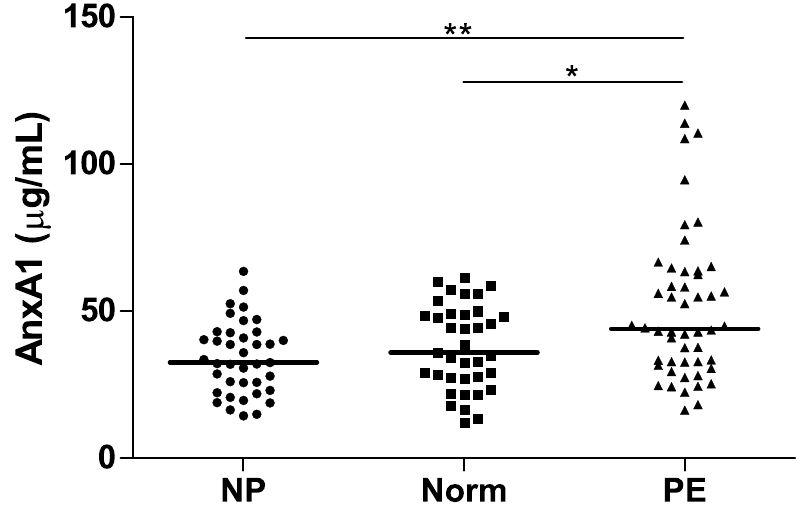
Fig 1. AnxA1 plasma levels in non-pregnant, normotensive pregnant and PE women. NP (non- pregnant women), Norm (normotensive pregnant women), PE (preeclamptic women). Horizontal bars represent median values for AnxA1 (micrograms/milliliter). ** P < 0.01, * P < 0.05. Plasma levels of AnxA1 were higher in PE women than in normotensive pregnant and non-pregnant women. No significant differences were found comparing non-pregnant and normotensive pregnant